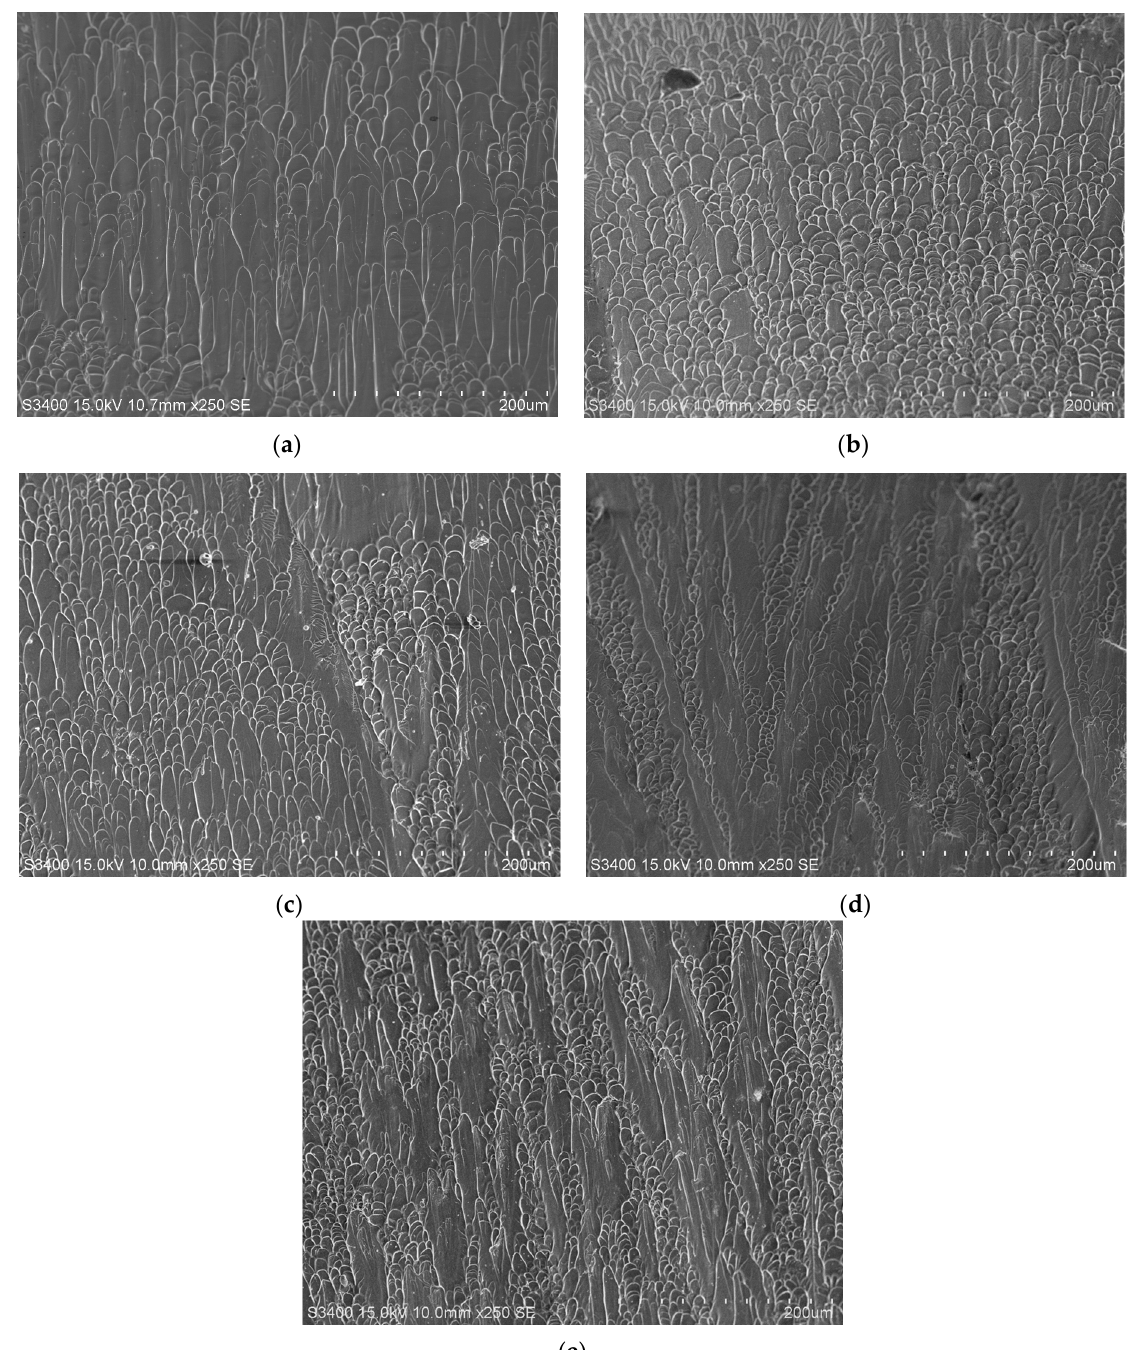
5 of 11 Figure 3. Compressive stress ‐ strain curves of the Cu 50 − x Zr 43 Al 7 Ag x ( x = 0, 3, 4, 5, 6) rods at room temperature. The fracture surface of a Cu 47 Zr 43 Al 7 Ag 3 alloy subjected to room temperature compression is displayed in Figure 4b. The appearance of the vein pattern is evidence of the ductile fracture